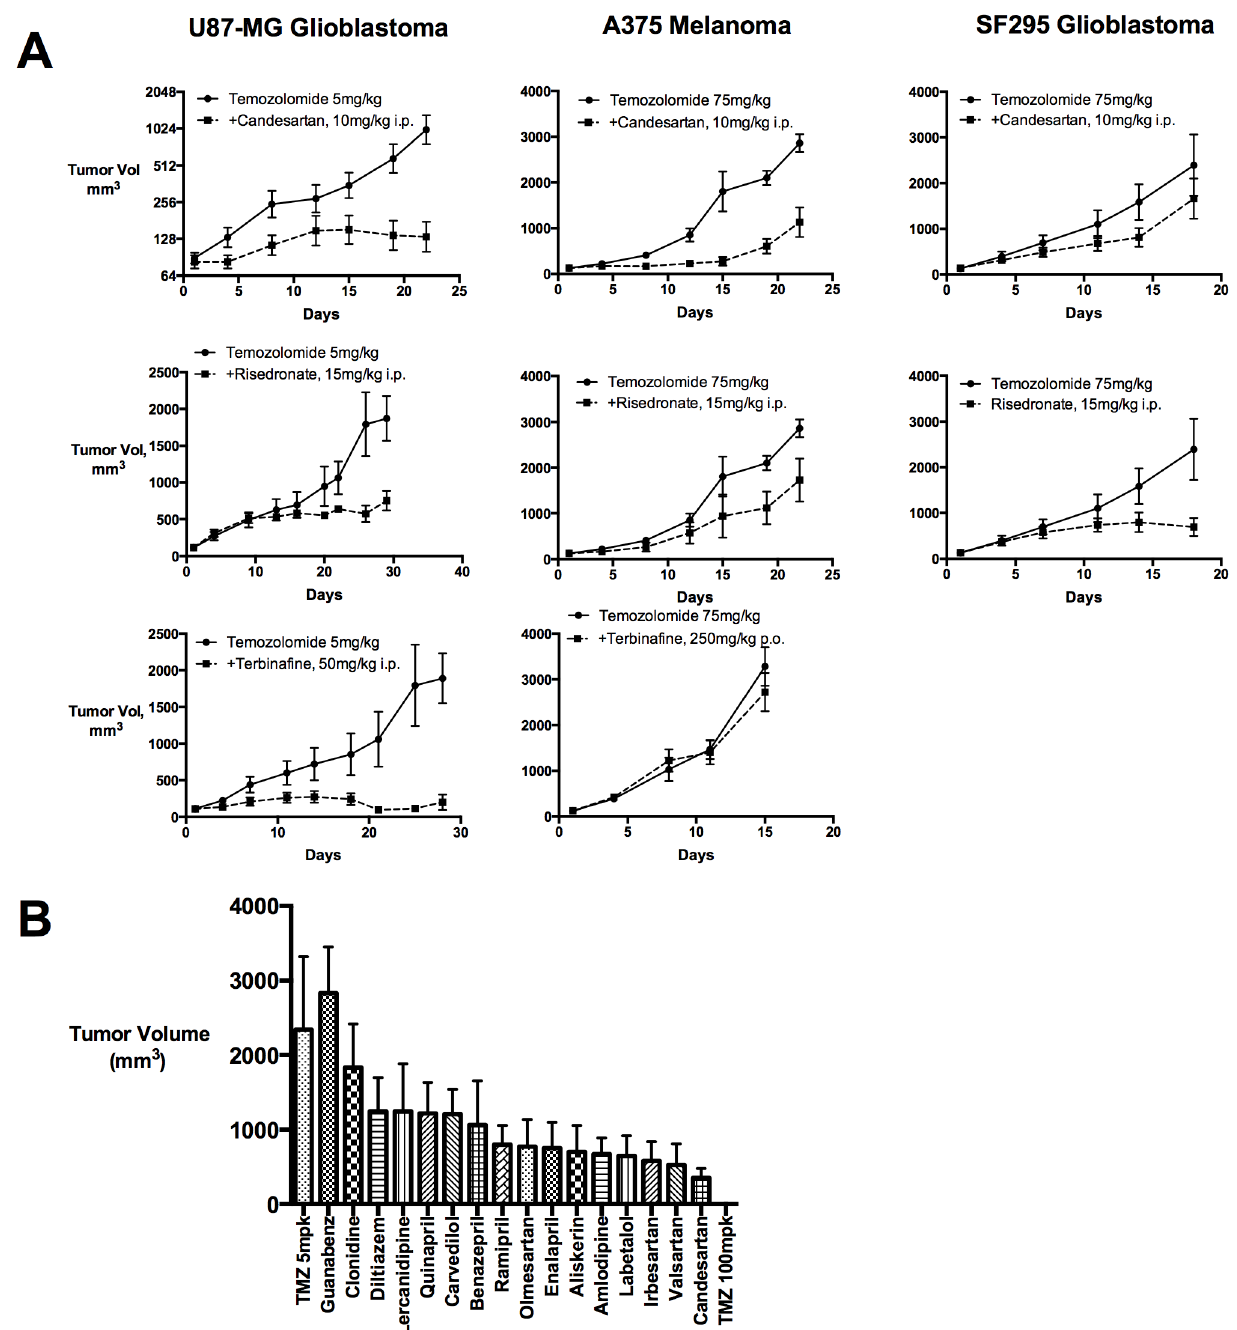
Figure 2. Screen validation and confirmation. A. Hit validation in additional models. Selected primary screen hits were tested in combination with sub-efficacious doses of temozolomide in a model of glioblastoma and melanoma xenograft models. To assess pharmacological effects terbinafine was dosed p.o in A375 model at a dose interval five times greater than its screening dose administered by i.p. route. In primary screen comparisons, risedronate was significant by survival analysis at a cut-off at 1000 mm 3 , but not 500 mm 3 . B. Hypertension drug combinations. Drugs were dosed in combination in the U87-MG model, at the dose in the primary screen, or as indicated in supplemental materials. Effects on tumor growth were assessed at Day 20 of the study. Means plus SEM shown (N=10); candesartan and temozolomide 100 mg/kg significant by M-ANOVA at p , 0.05.